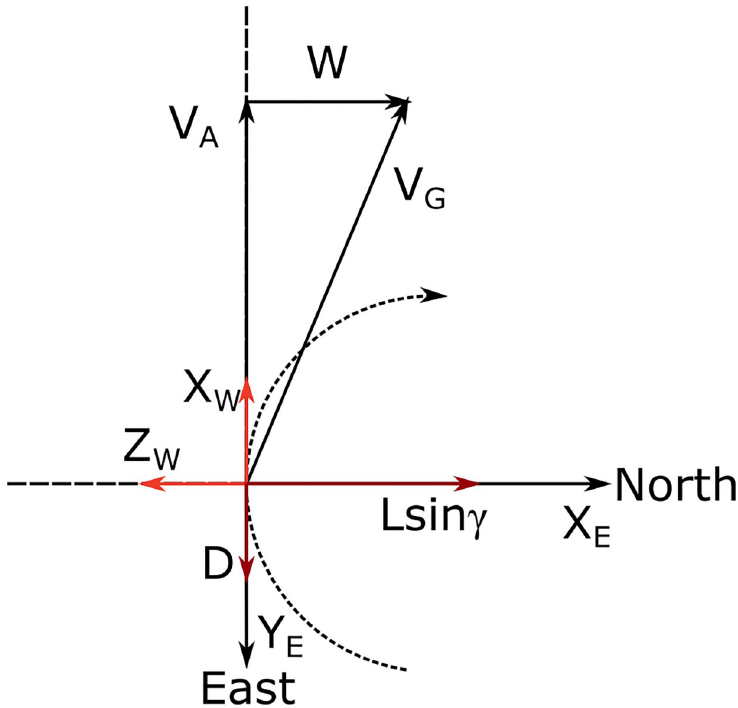
Fig 5. Sketch for the upper turn phase. Velocity vectors and forces in the horizontal plane for the middle of the upper turn ( ψ = 3 π /2) and for level flight ( γ = 0).